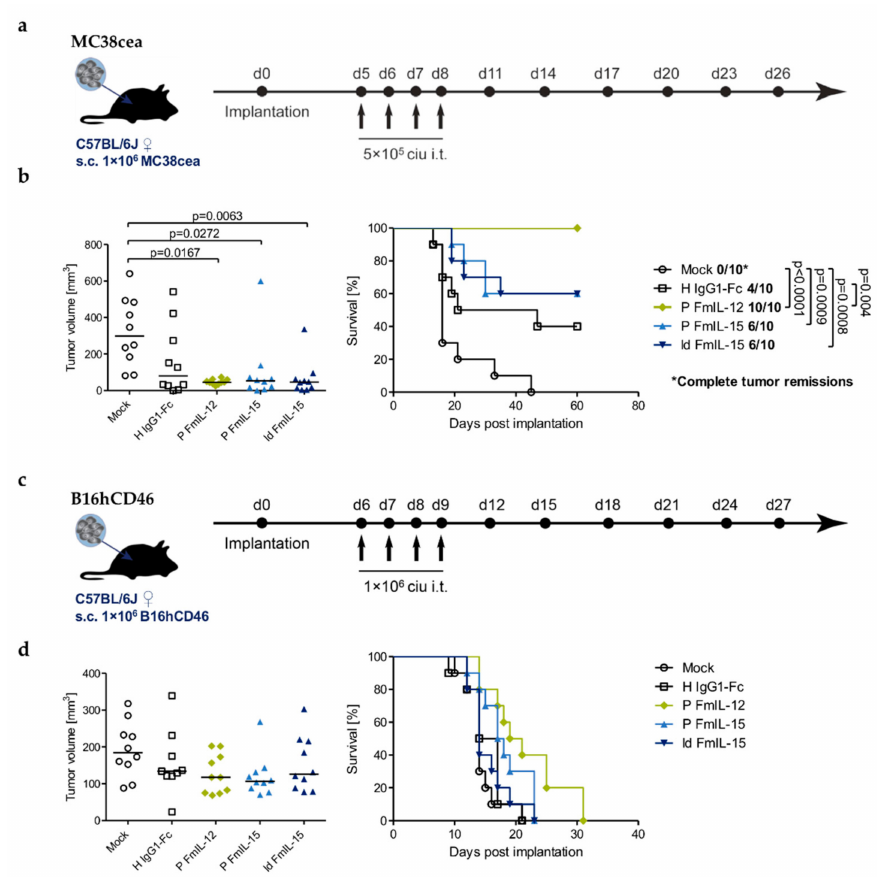
Figure 5. Therapeutic e ffi cacy. C57BL / 6J mice bearing s.c. MC38cea ( a , b ) or B16hCD46 ( c , d ) tumors were treated by intratumoral (i.t.) injections of 1 × 10 6 ciu of indicated MeVac variants on four consecutive days. ( a , c ) Treatment schedules. ( b , d ) Left panels: Tumor volume distribution on day 13 ( b ) and 10 ( d ), which was the last day when all mice were alive. Values for individual animals and group median are shown. Right panels: Kaplan–Meier survival